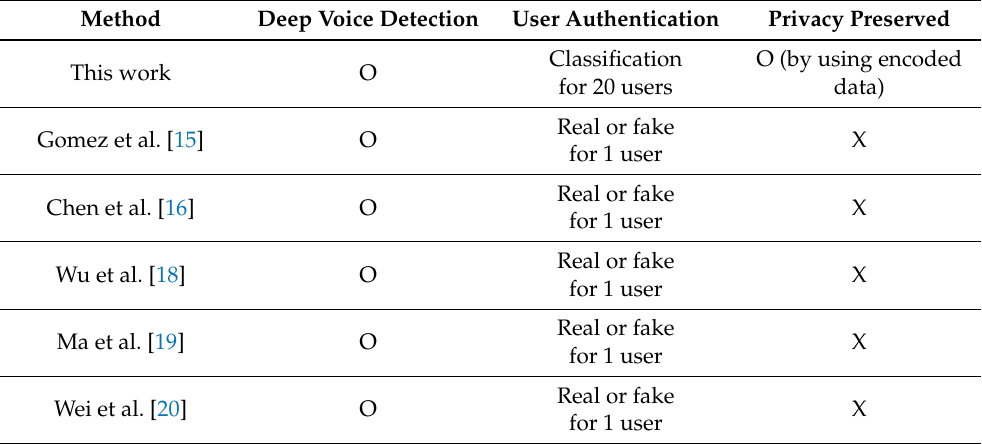
Table 6. Comparison with previous works. O = provided method and X = not provided